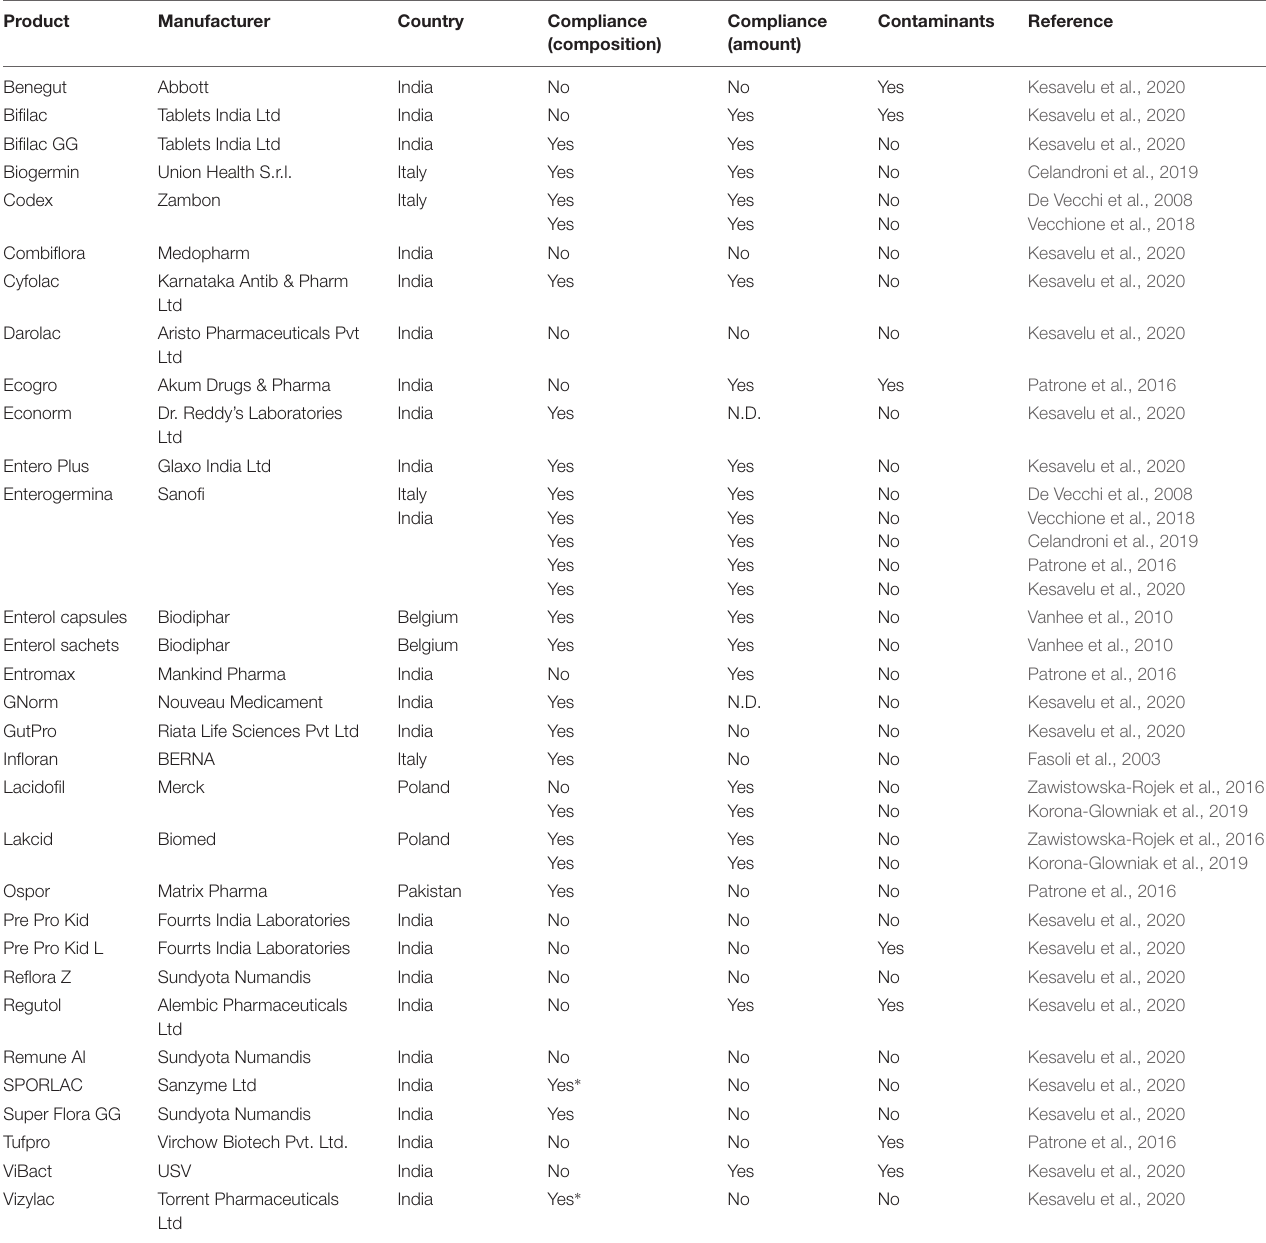
TABLE 1 | Compliance with the label claims of probiotic drugs marketed worldwide: focus on the microbial composition, amount of living cells, and presence of contaminant microorganisms.